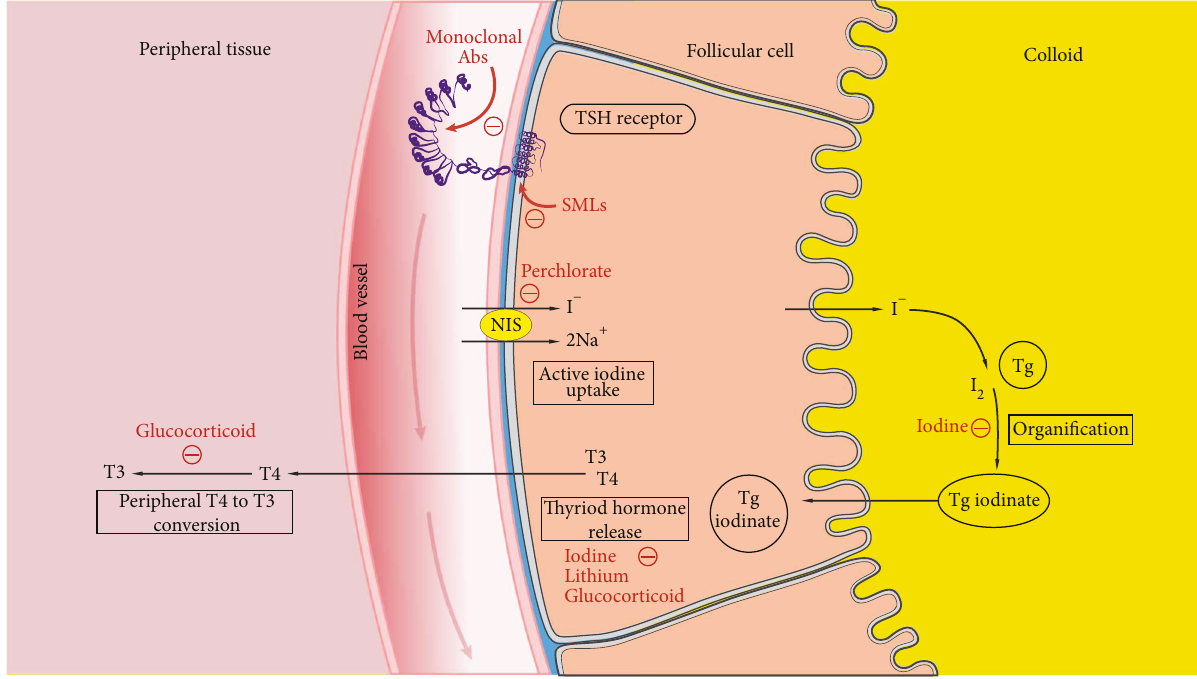
Figure 1: Mechanism of nonthionamide antithyroid drugs. Iodine-containing compounds mainly inhibit thyroid hormone release and transiently inhibit organi fi cation. Lithium also inhibits thyroid hormone release and may inhibit thyroid hormone synthesis. Perchlorate inhibits active iodide uptake by competitively binding with NIS. Glucocorticoid inhibits peripheral T4 to T3 conversion and may inhibit thyroid hormone secretion. MAbs act at the ectodomain of the TSH receptor while SMLs act at the transmembrane domain of the TSH receptor. MAbs: monoclonal antibodies; NIS: sodium iodide symporter; SMLs: small-molecule ligands; Tg: thyroglobulin; TSHR: thyroid- stimulating hormone